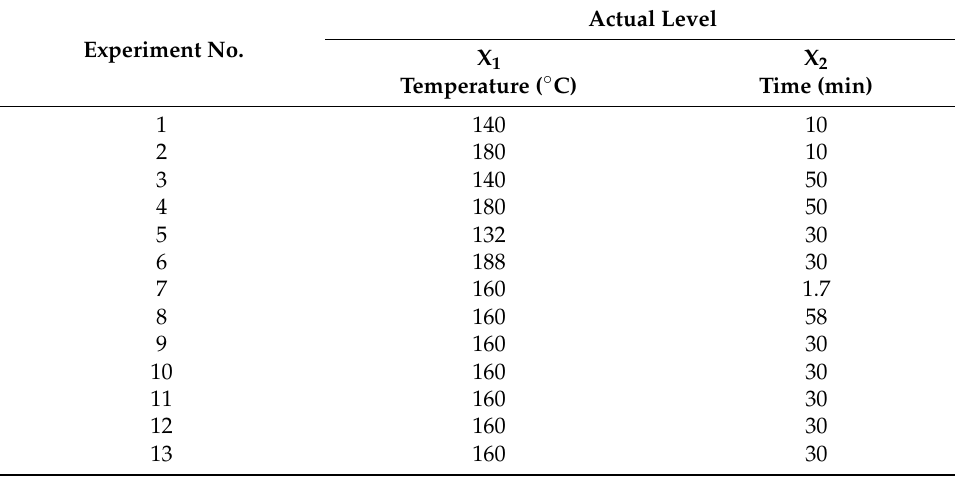
Table 2. Experimental runs with actual values of independent variables.